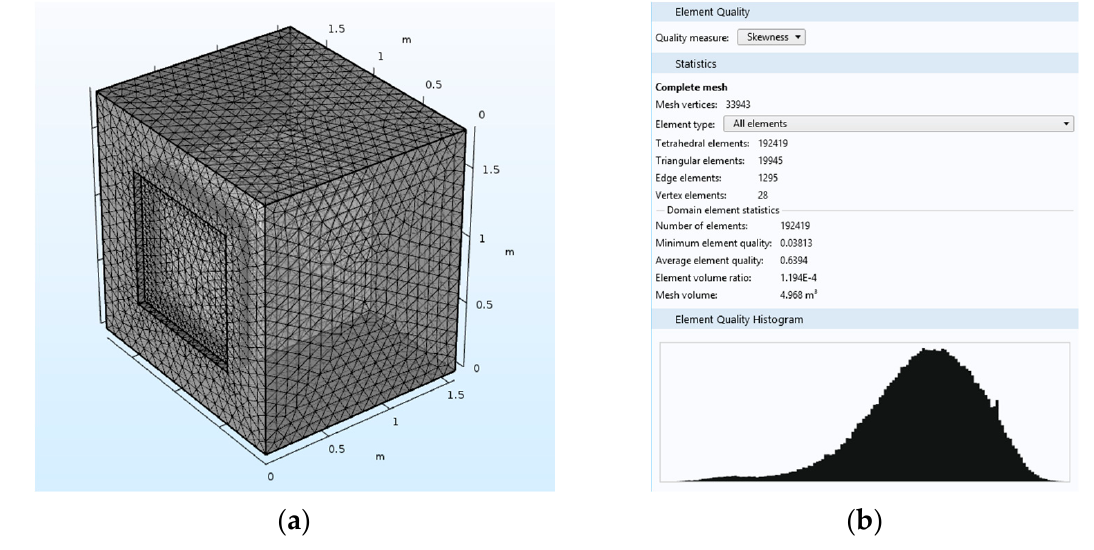
Figure 3. ( a ) Mesh during numerical calculations; ( b ) Mesh statistics.